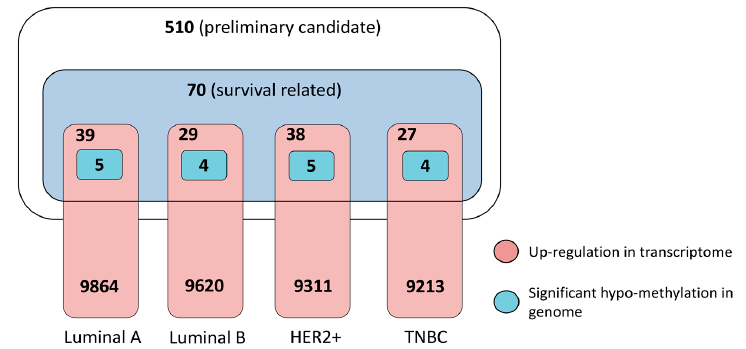
Figure 4. Statistical summarization of final candidate targets for four breast cancer subtypes from multifaceted assessment.